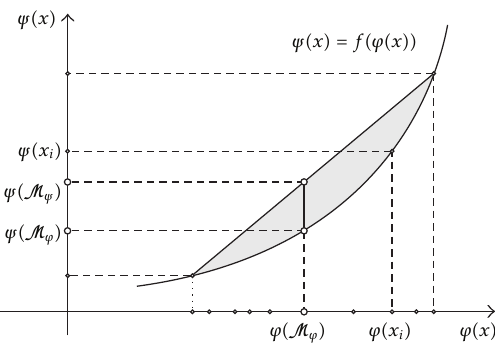
Figure 2: The ψ -order among quasiarithmetic means M ϕ and M ψ for ϕ -convex and increasing ψ